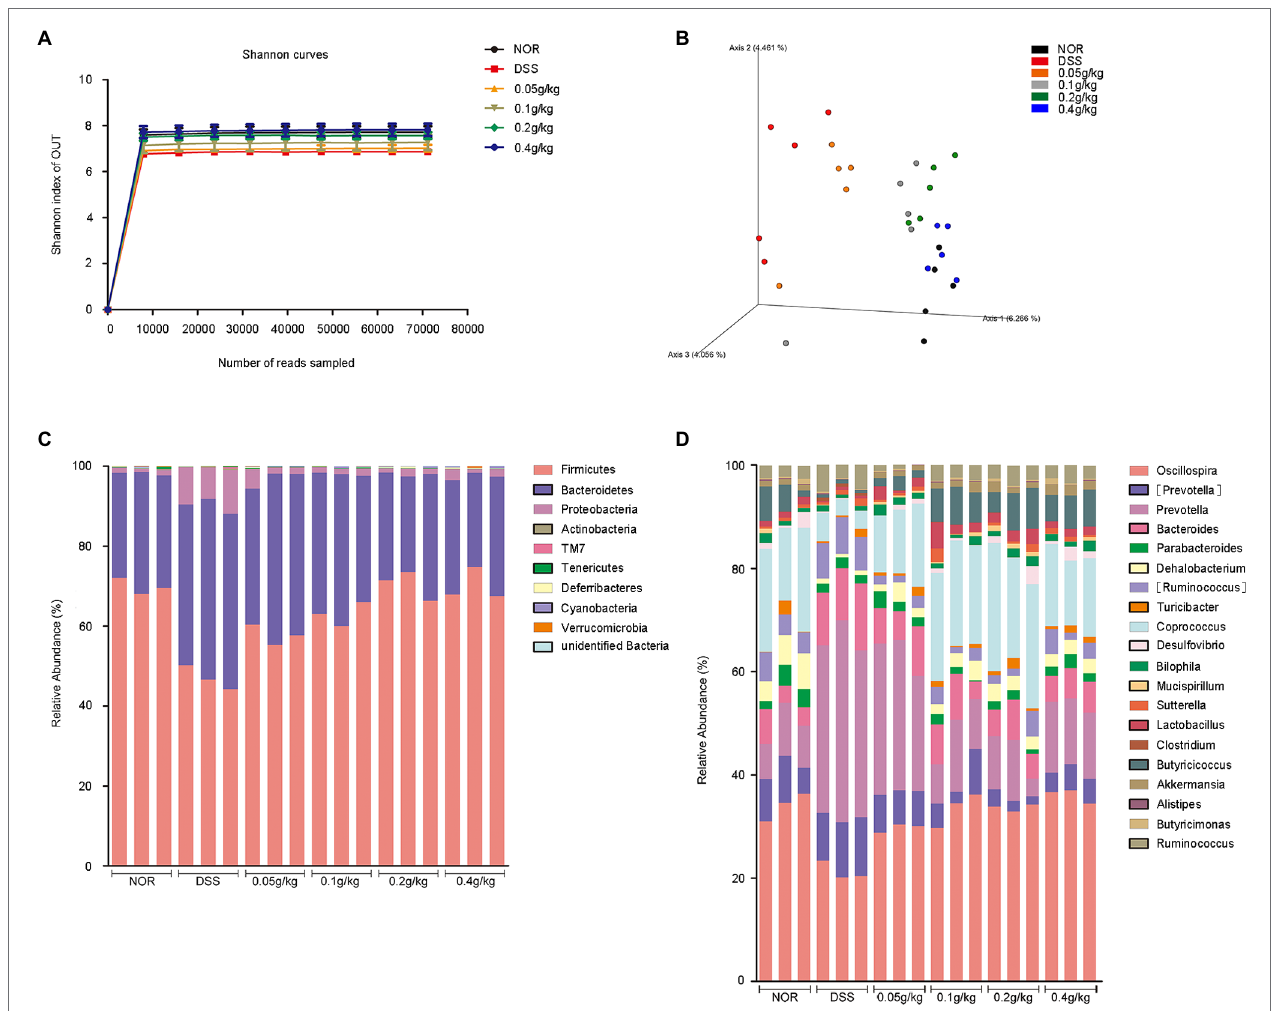
FIGURE 8 | Taxonomic changes in the microbiota of the mouse cecum induced by MLF. A microbiome analysis was conducted using cecal samples collected from five mice per group. (A) Rarefaction curves for each group calculated at OTU level of sequence similarity clustering. (B) Principal coordinates analysis of the cecal microbiota structure measured by weighted UniFrac distance. (C) Average relative abundances of taxa at the phylum level. (D) Average relative abundances of taxa at the genus